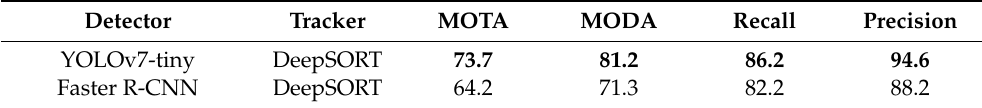
Table 2. CLEAR MOT metrics of YOLOv7-tiny and Faster-RCNN detectors with the DeepSORT tracker.